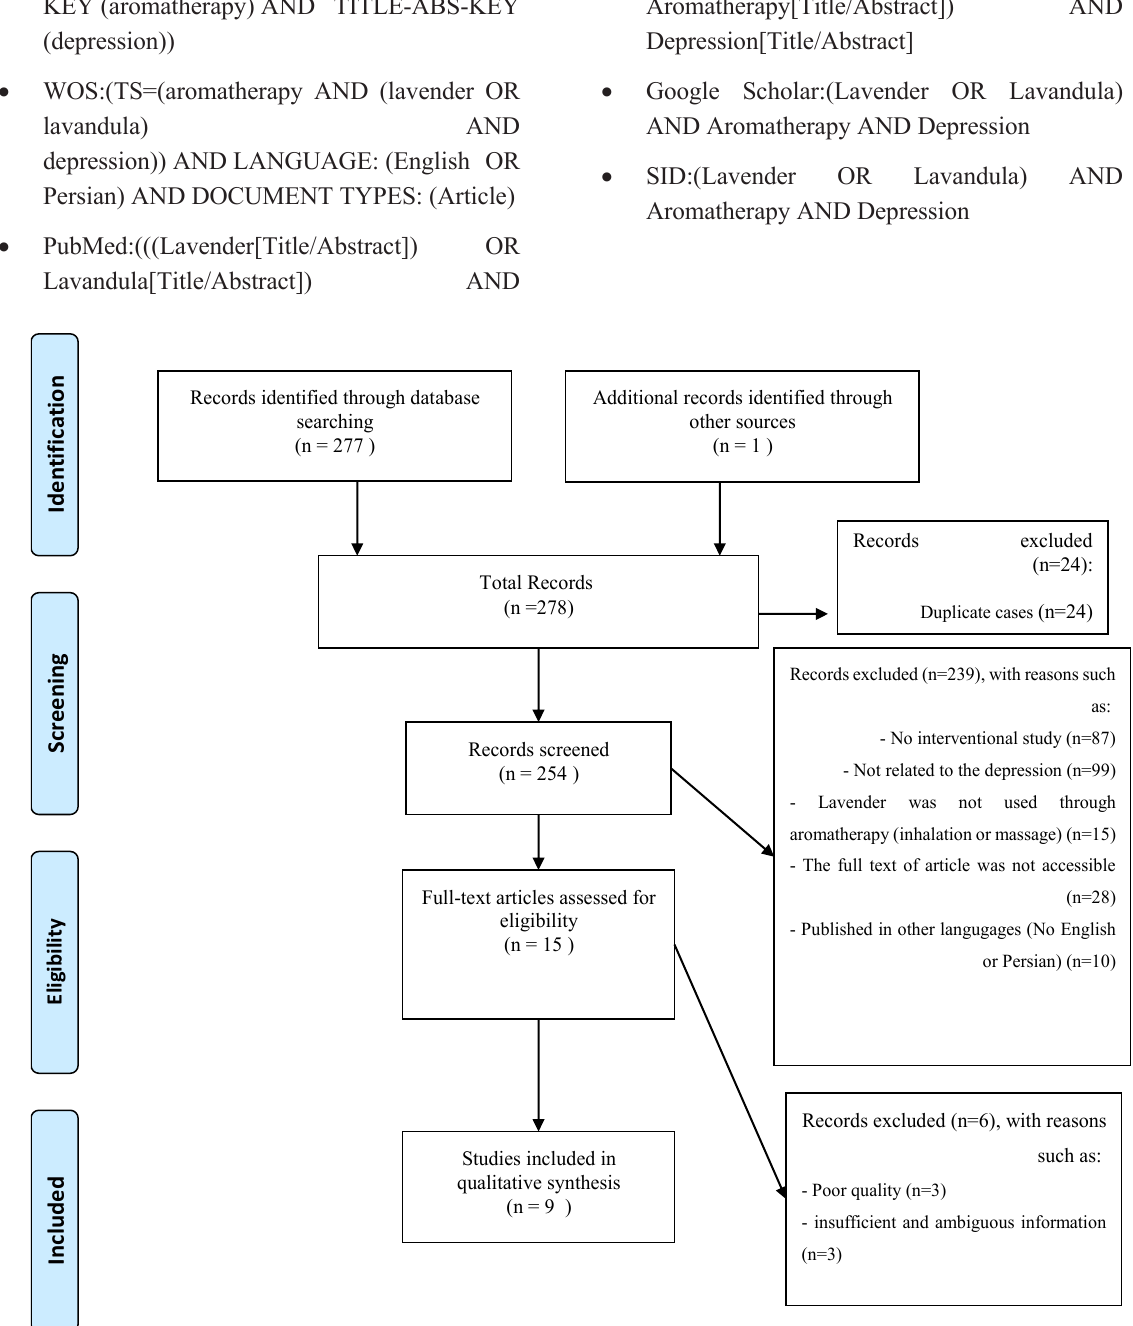
Figure 1. Flowchart of article selection using PRISMA